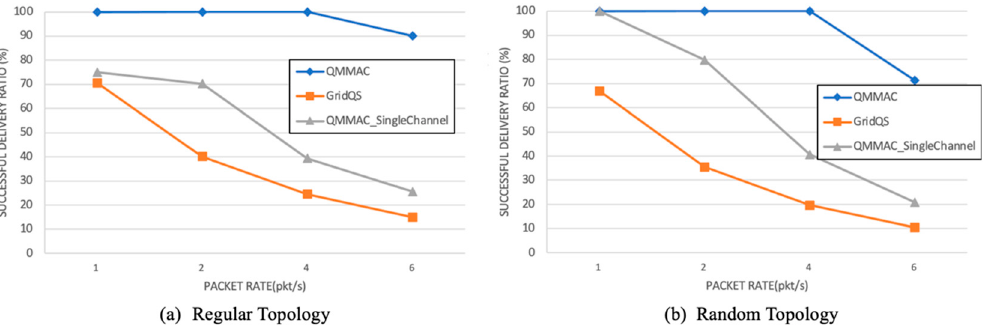
Figure 14. Throughput.